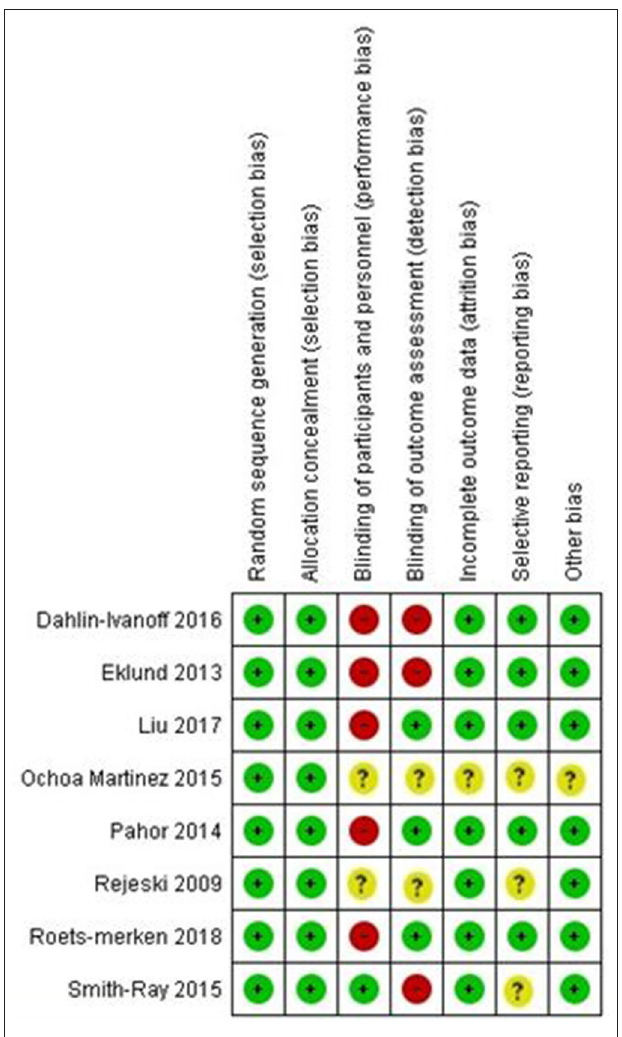
FIGURE 2 | Risk of bias summary: review author’s judgments about each risk of bias item for each included study.